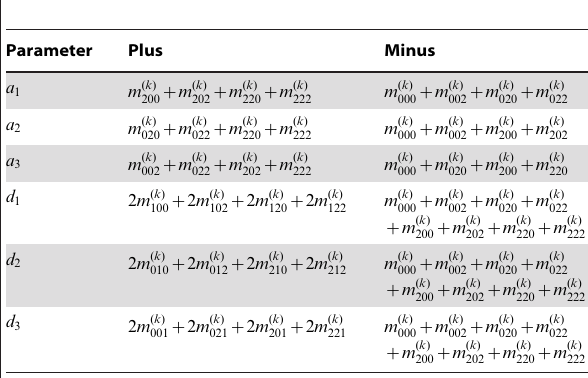
Table 5. The x 2 test statistics for the main epistatic effect